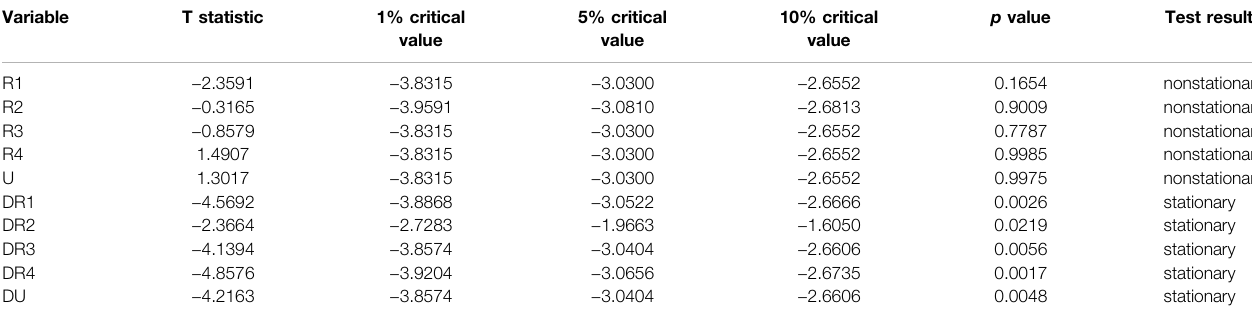
TABLE 3 | ADF unit roots test of variable